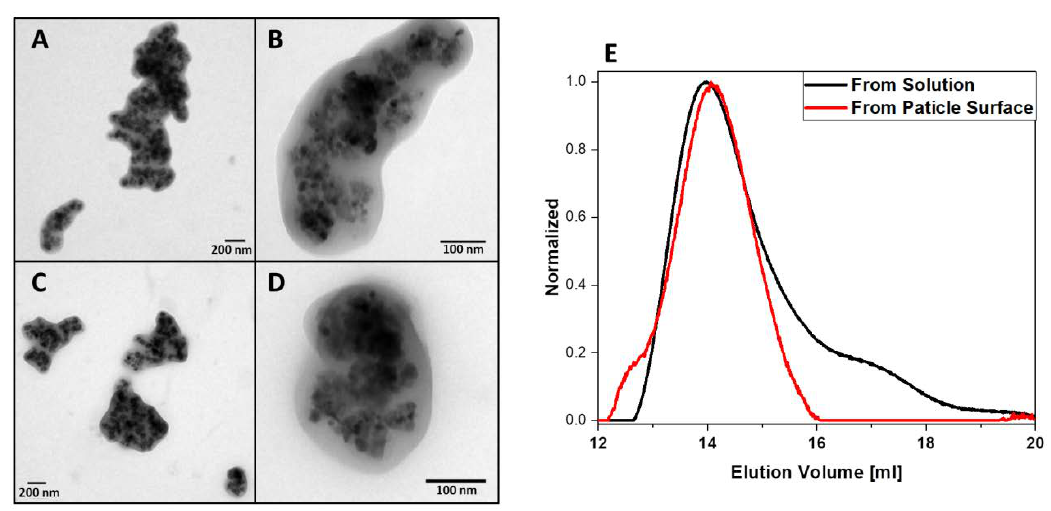
Figure 9. ( A–D ) TEM micrographs of PS@MPTS@MCNP; ( E ) SEC elution traces (DMAc / LiCl) of PS synthesized by free radical polymerization in the presence of MPTS@MCNP: black line: PS from reaction solution ( M n = 62.600 kg mol − 1 ; Ð = 2.78); red line: PS obtained from the particle surface ( M n = 165 kg mol − 1 ; Ð = 1.80).